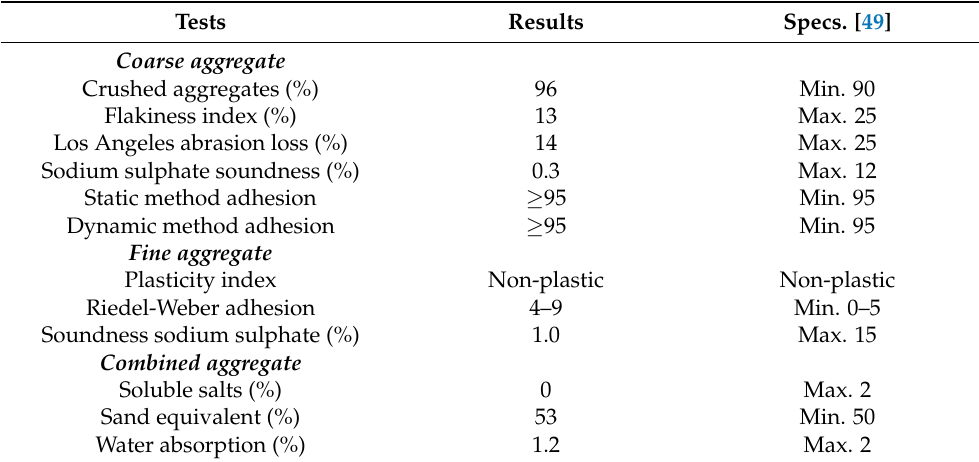
Table 4. Physical properties of aggregates used.